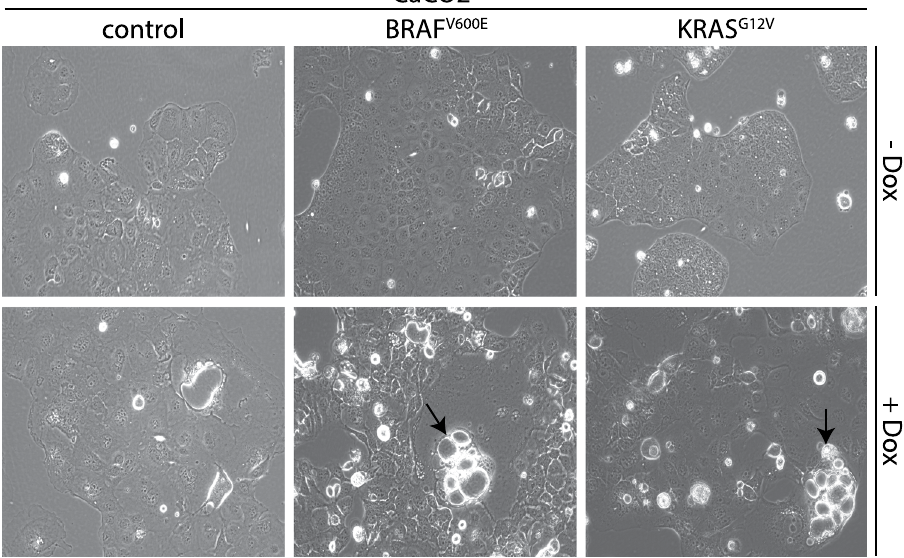
Figure 1. Expression of BRAF V600E and KRAS G12V resulted in cytoskeletal rearrangement and Mucin production. CaCO2-control, CaCO2-BRAF V600E and CaCO2-KRAS G12V cells cultivated with 1.0 g/L glucose were supplemented with Doxycycline for 16 days. Vacuoles containing Mucin are depicted by arrows. Pictures were taken with Zeiss Axio Z1 microscope using 200x